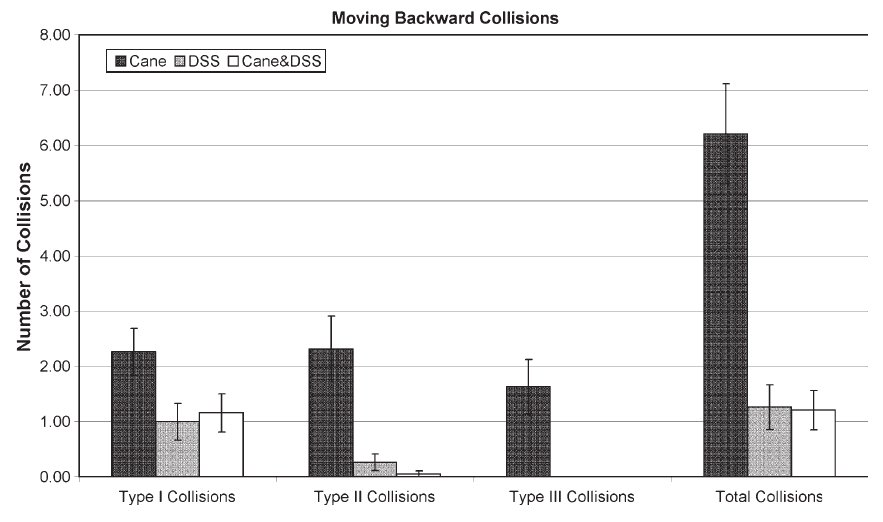
Fig. 6. Number of